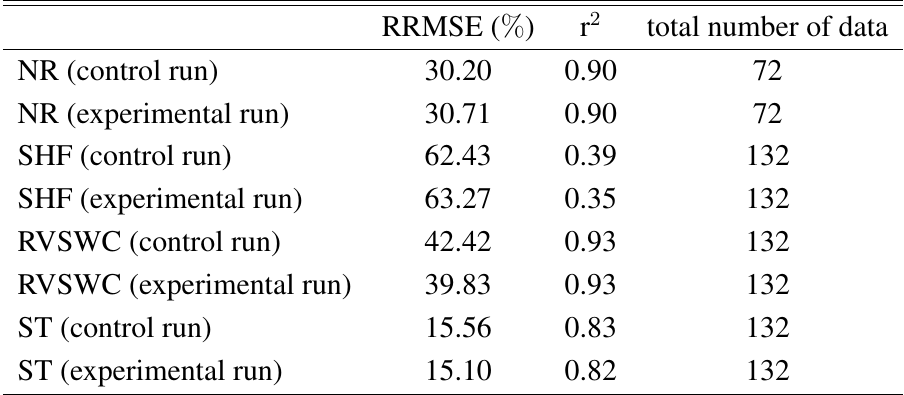
Table 2. Indices of agreement between measured and simulated daily values of NR, SHF, RVSWC and ST from the control and the experimental runs. For NR less data are available due to the late instrument